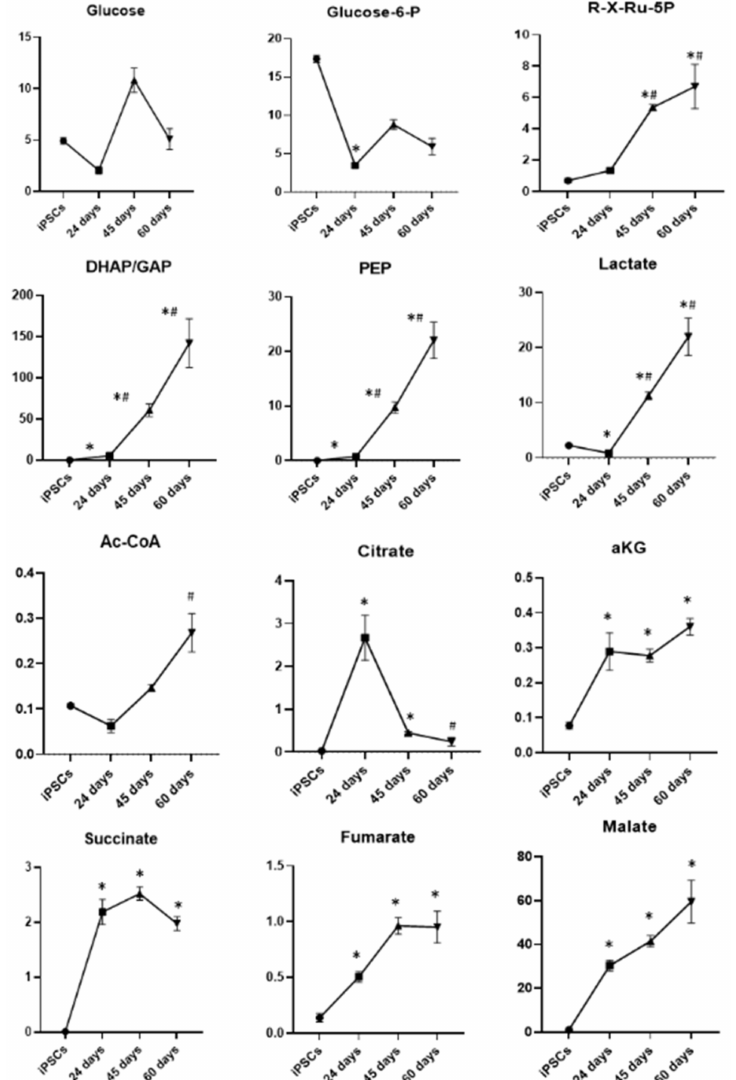
Figure 8. Graphic representation of the major metabolic changes related to glycolysis, pentose–phosphate pathway and tricarboxylic acid cycle in iPSCs and DA neurons at days 24, 45 and 60 of differentiation: glucose-6-phosphate, glucose-6-P; DHAP/GAP, dihydroxyace- tone phosphate/glyceraldehyde 3-phosphate; PEP, phosphoenolpyruvate; R-X-Ru-5P, ribose-5- phosphate/xylulose-5-phosphate/ribulose-5-phosphate; acetyl-CoA, acetyl coenzyme A; α KG, α - ketoglutarate. Data represent mean ± SEM from at least triplicates of cultures from iPSCs and DA neurons at days 24, 45 and 60 of differentiation. * Significant v. iPSCs, # significant v. 24